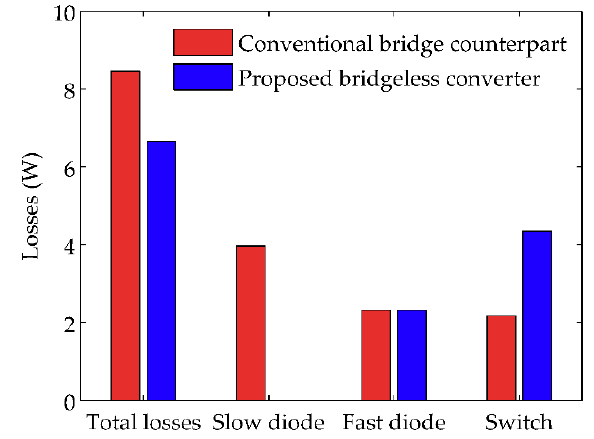
Figure 7. The calculated conduction losses of semiconductors.